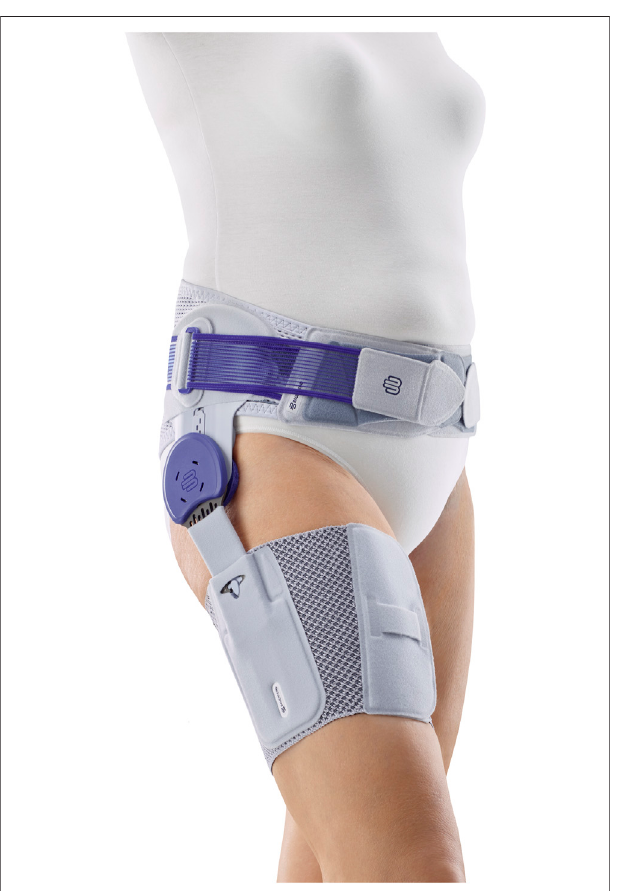
FIGURE 2 | CoxaTrain hip brace, ©Bauerfeind